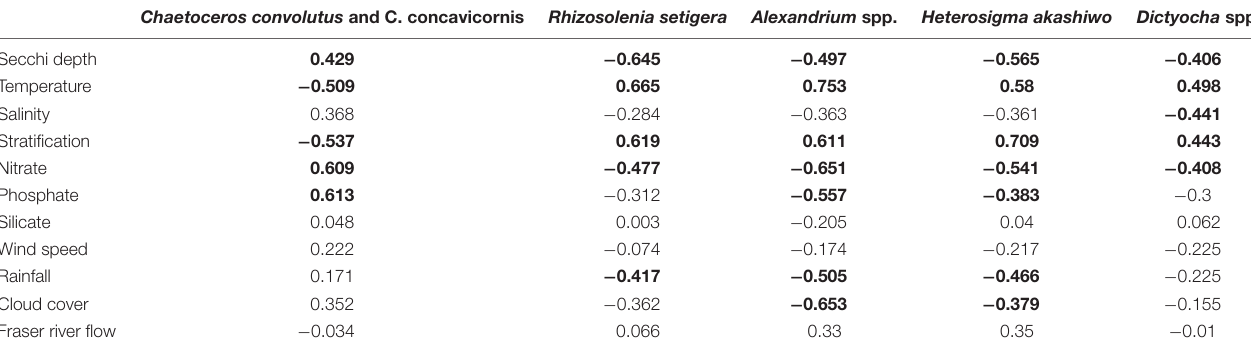
TABLE 5 | Examination of intra-annual relationships using Pearson Product Moment Correlations ( r ) between mean monthly concentrations of HABs taxa and various physical and chemical variables from March to September 2015–2018 averaged over the entire SoG ( n = 28). Chaetoceros convolutus and C. concavicornis Rhizosolenia setigera Alexandrium spp. Heterosigma akashiwo Dictyocha